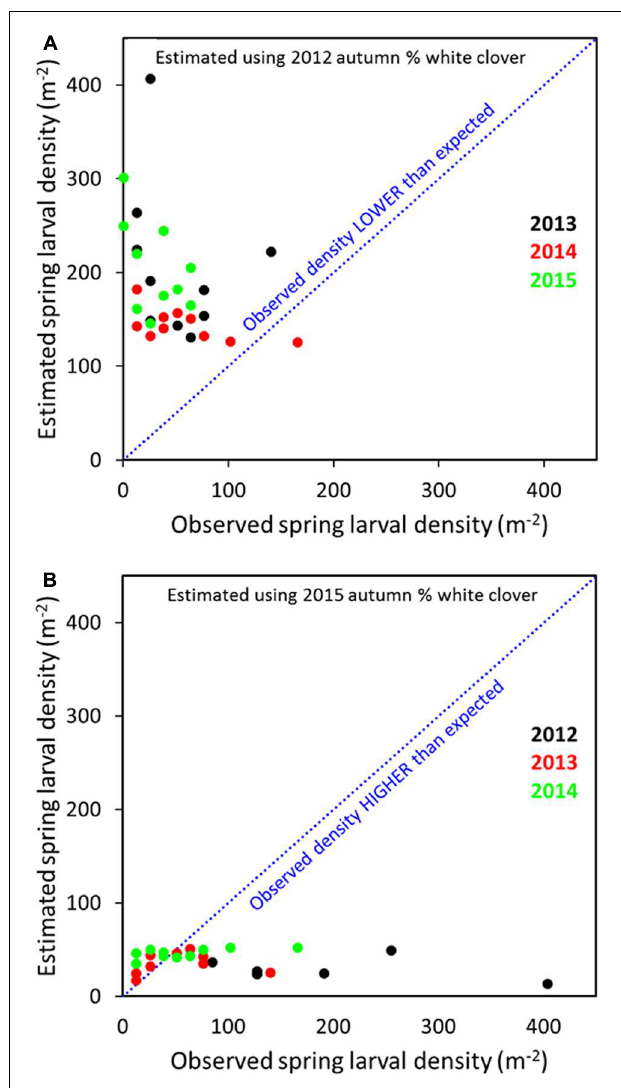
FIGURE 8 | Predicted and observed S. obsoletus larval densities for 2013–2015 populations based on 2012 log 10 spring larvae data, with % autumn white clover as the explanatory variable (A) and 2012–2014 larval populations based on 2015 spring larval data with % autumn white clover as the explanatory variable